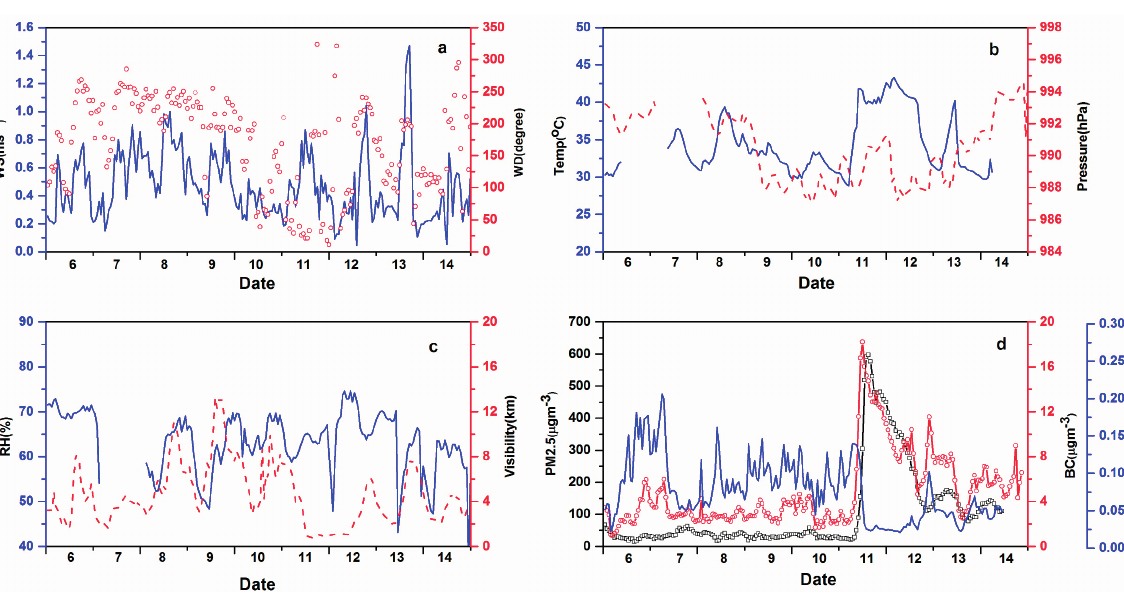
Figure 3. Time series variations of meteorological parameters and pollutant mass concentrations (BC and PM ) at LIESMARS site during 6–14 June 2012. ( a ) Wind 2.5 direction (degrees) and wind speed (m·s − 1 ); ( b ) Temperature (°C) and atmospheric pressure (hPa); ( c ) Visibility (km) and relative humidity (%), and ( d ) BC and PM mass 2.5 concentrations and ratio between BC and PM 2.5